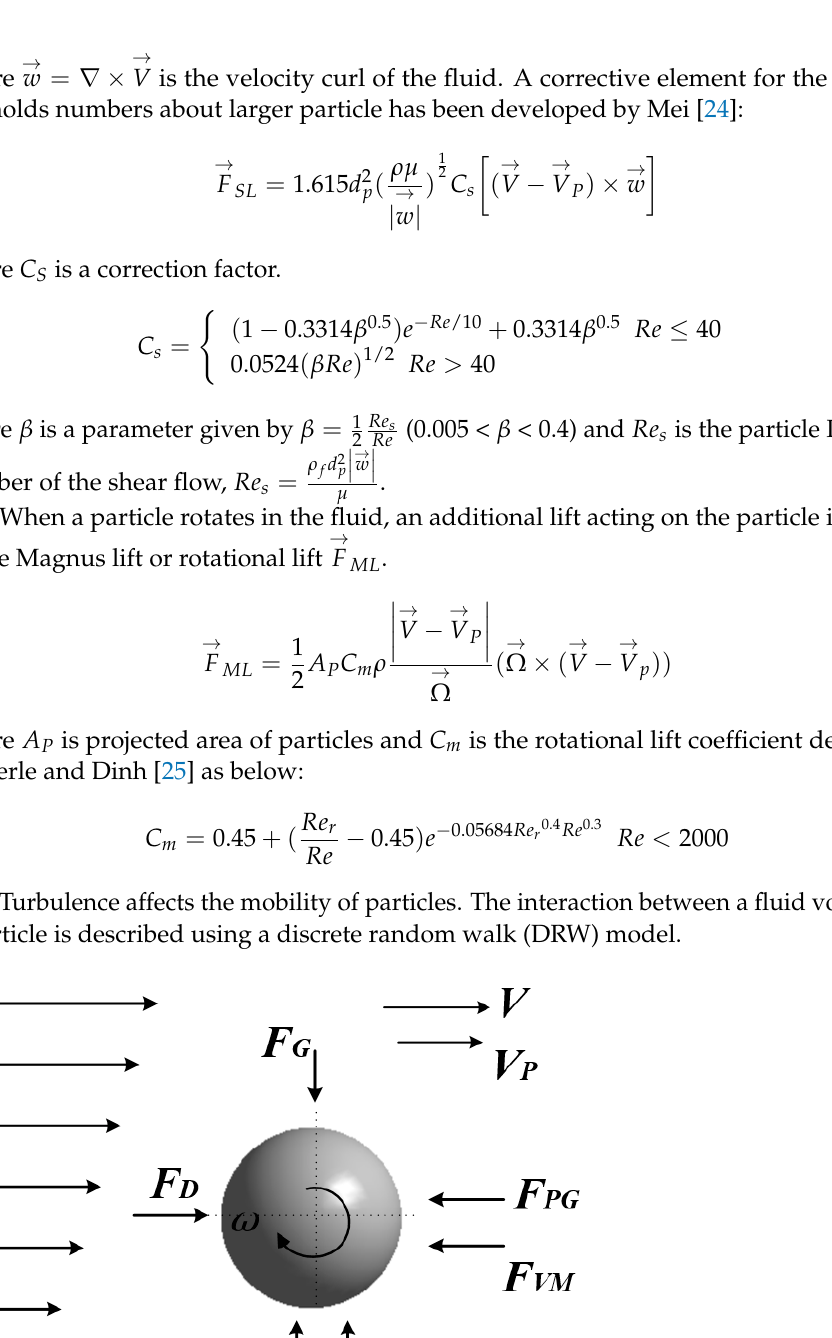
  represents virtual mass force. D F repre ‐   represents gravity. SL F represents Shear lift and